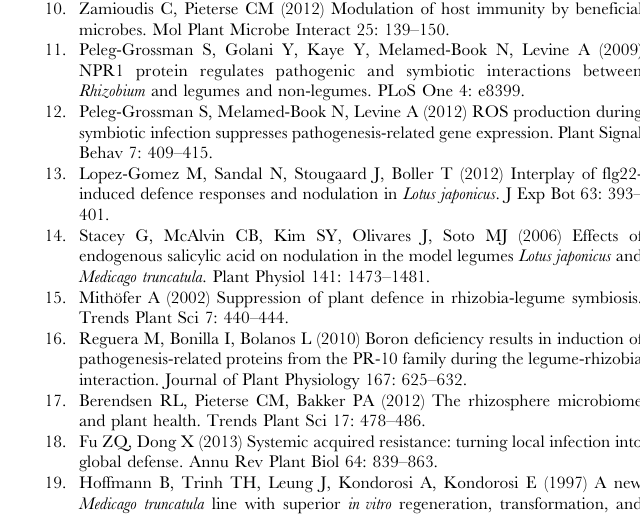
reporter construct were cultivated on Agar- (B) and agarose-BNM (C), scales bars represent 100 m m. (TIF) Figure S6 Hypothetical model for the effect of growth conditions on DNF2 requirement for symbiosis. In M. truncatula WT and dnf2 nodules from plants cultivated on non- defense priming environments (agarose- and Phytagel-based media), the defense elicitation does not reach the threshold for defense reactions and the symbiosis is efficient (central part of the figure). When plants are cultivated on defense priming environ- ments (agar- and ulvan supplemented agarose-media) elicitation reaches the threshold for defenses (left and right part of the figure) but, in the WT nodules, DNF2 (represented by a green box) prevents defense reactions to a large extent. In contrast, the dnf2 mutant nodules develop defense reactions. Table S1 List of primers used during this study. Table S2 Ulvan triggers the DNF2 requirement for